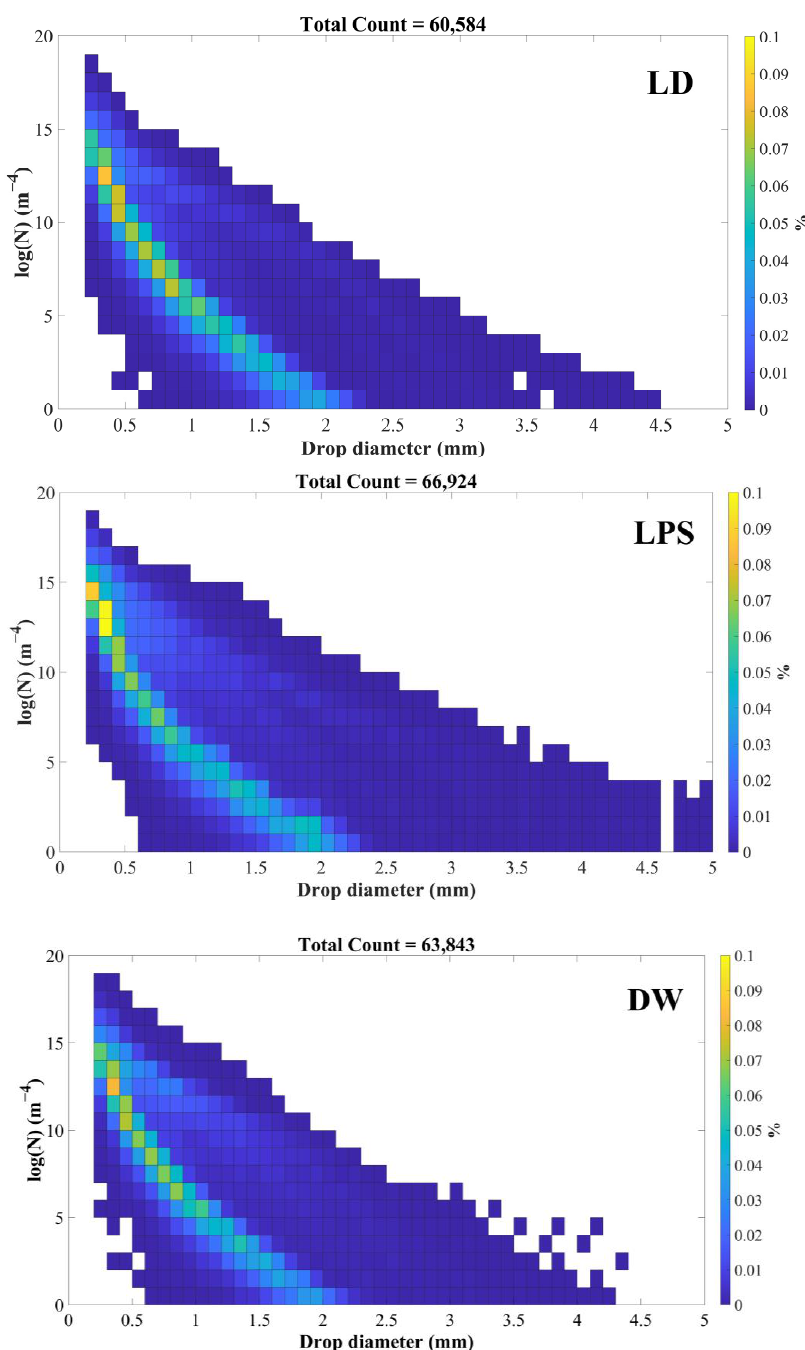
Figure 9. Probability density functions of the log (N) of the RSD from stratiform rainfall at LD, LPS,